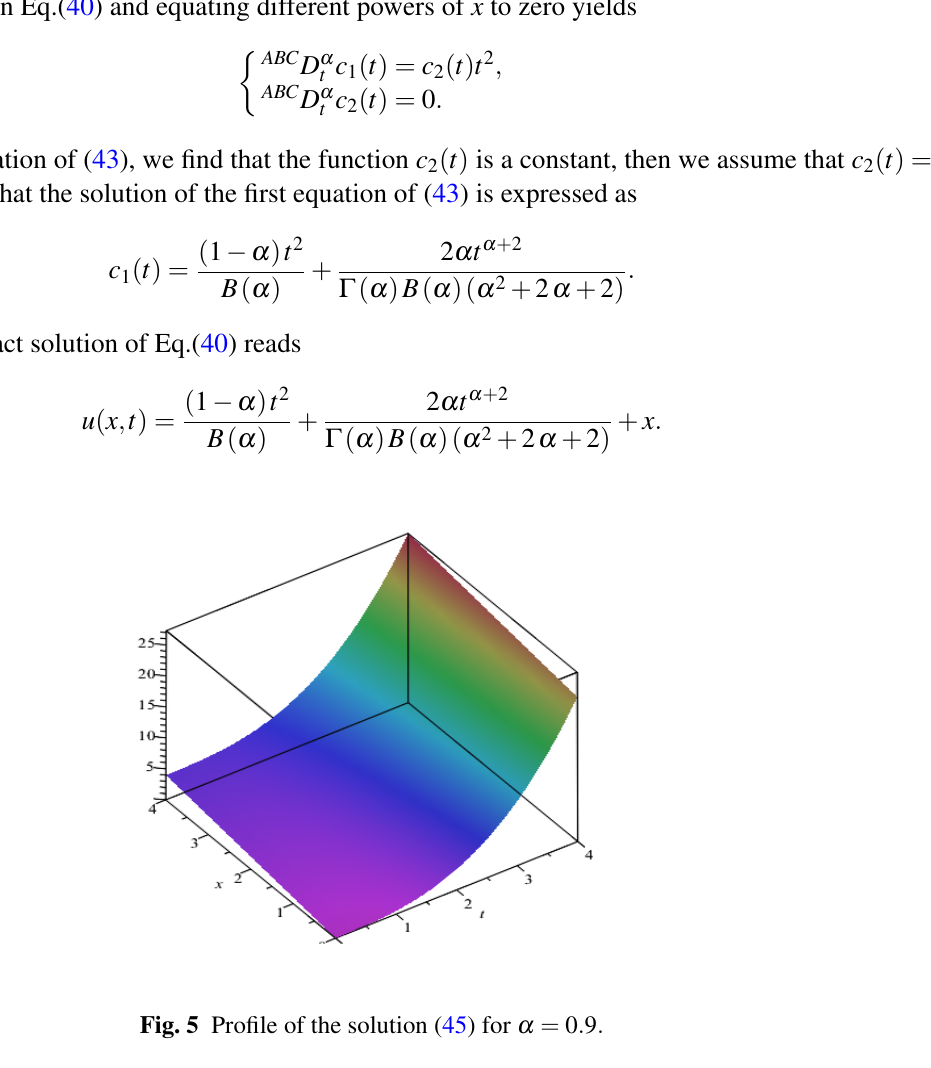
Fig. 5 Profile of the solution (45) for α = 0 . 9